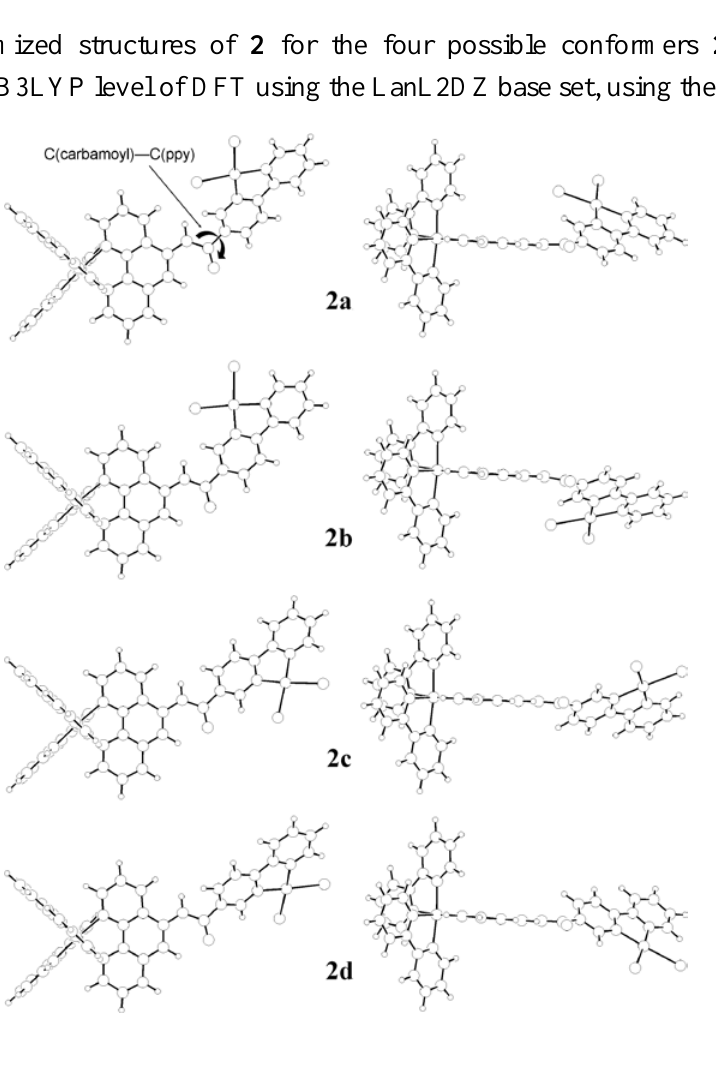
Figure 4. Optimized structures of 2 for the four possible conformers 2a - d in